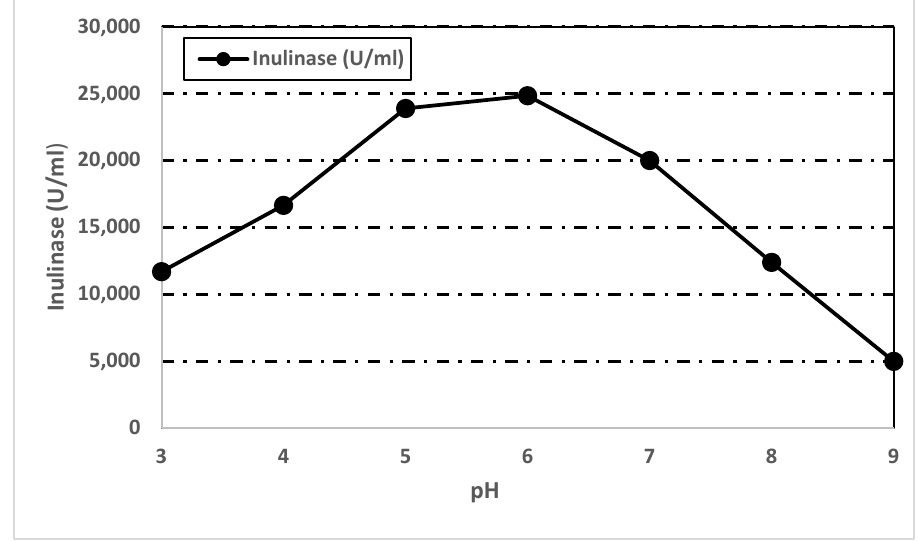
Figure 5. pH optima of the purified inulinase from Rhizopus oryzae NRRL 3563.